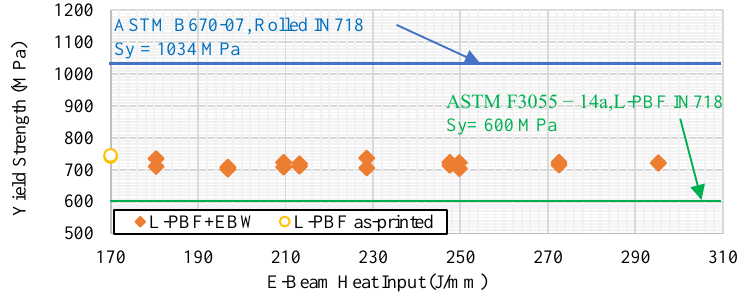
Figure 13: Effect of heat input on the yield strength of the EBW’ed samples